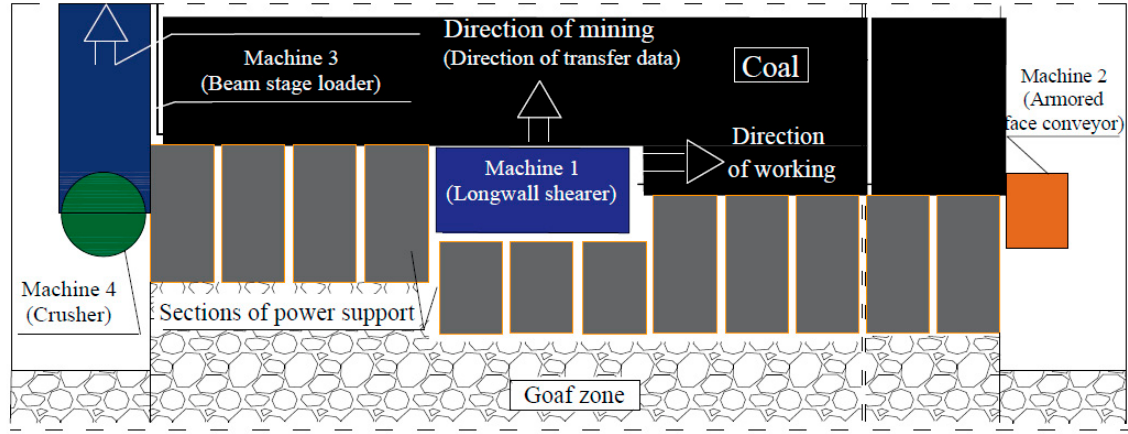
Figure 1. A mechanized longwall system in a longwall area.